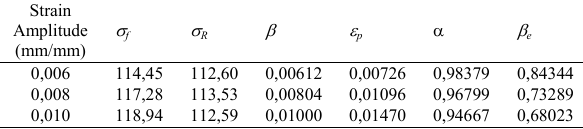
Table 4. Bauschinger effect factor calculation result